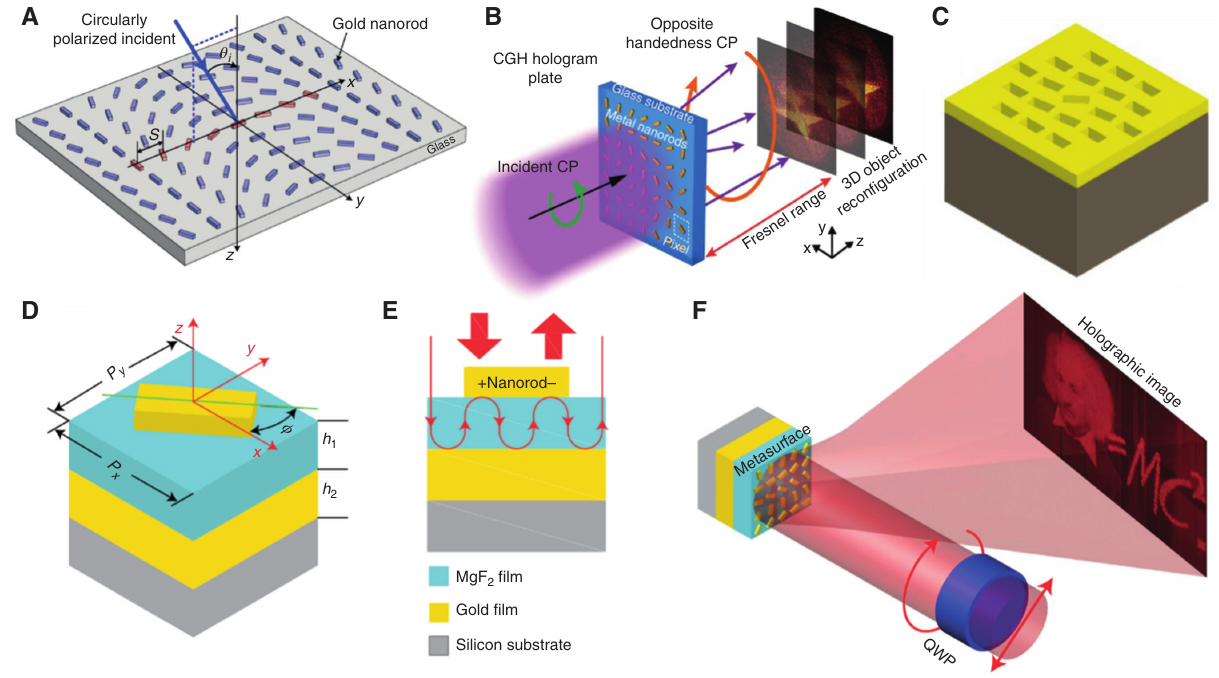
Figure 7: Illustration of geometric metasurfaces based on metallic nanostructures. (A) Metallic nanorods with different orientations to generate geometric phases [66]. (B) Metallic nanorods to generate 3D GEMS holograms [67]. (C) Metallic hole nanostructures [68]. (D–F) MIM structure to build high-efficiency GEMS and its application in holography [69]. Reprint permission obtained from